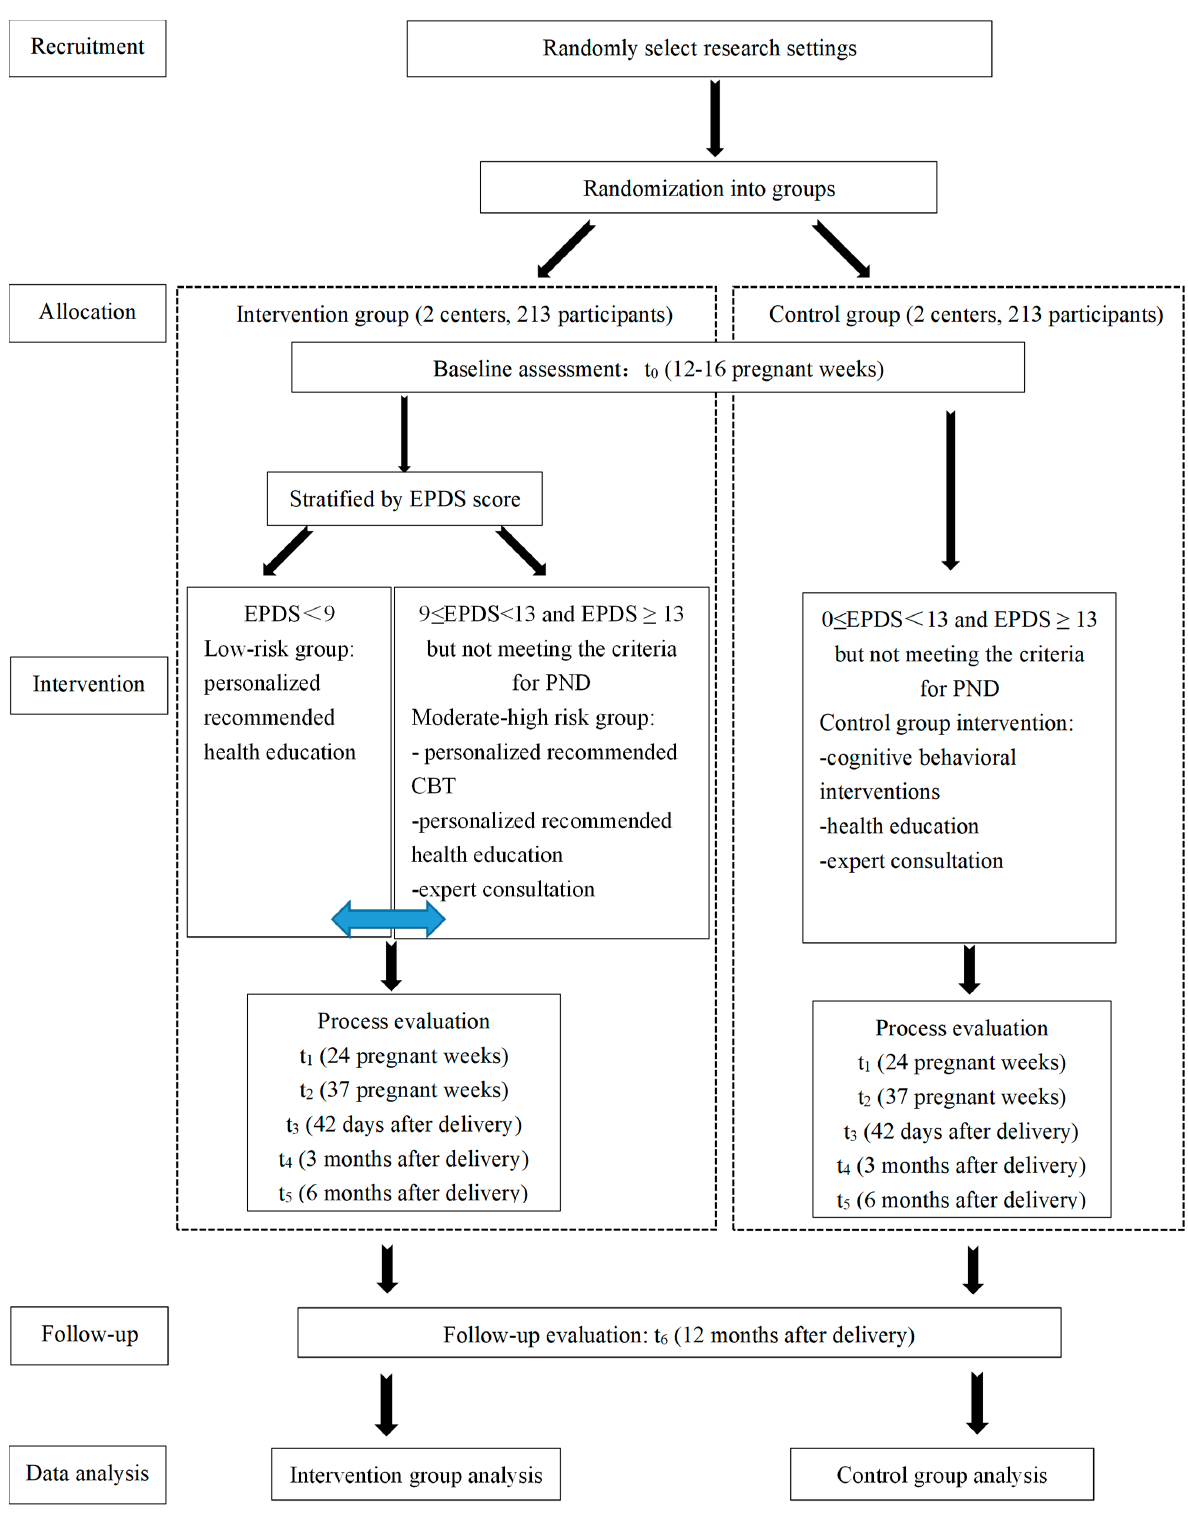
Figure 1. Flow Chart.